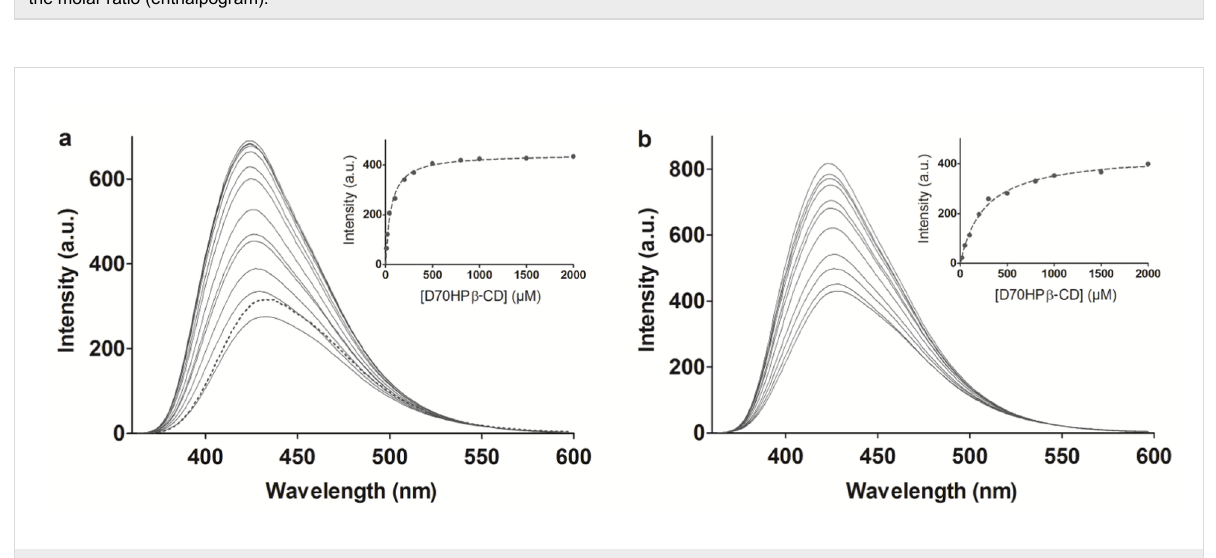
Figure 2: Fluorescence emission spectra of a) D70GPCPT and b) D10GPCPT recorded at different concentrations (0–2 mM β -CD) of D70HP β -CD. The dotted line in a) is the emission spectra of the D70GPCPT polymer with 2 mM of free β -CD. The inserts are the variation of FI at 430 nm plotted as a function of D70HP β -CD concentration, with FI of the CPT polymer solutions in the absence of D70HP β -CD